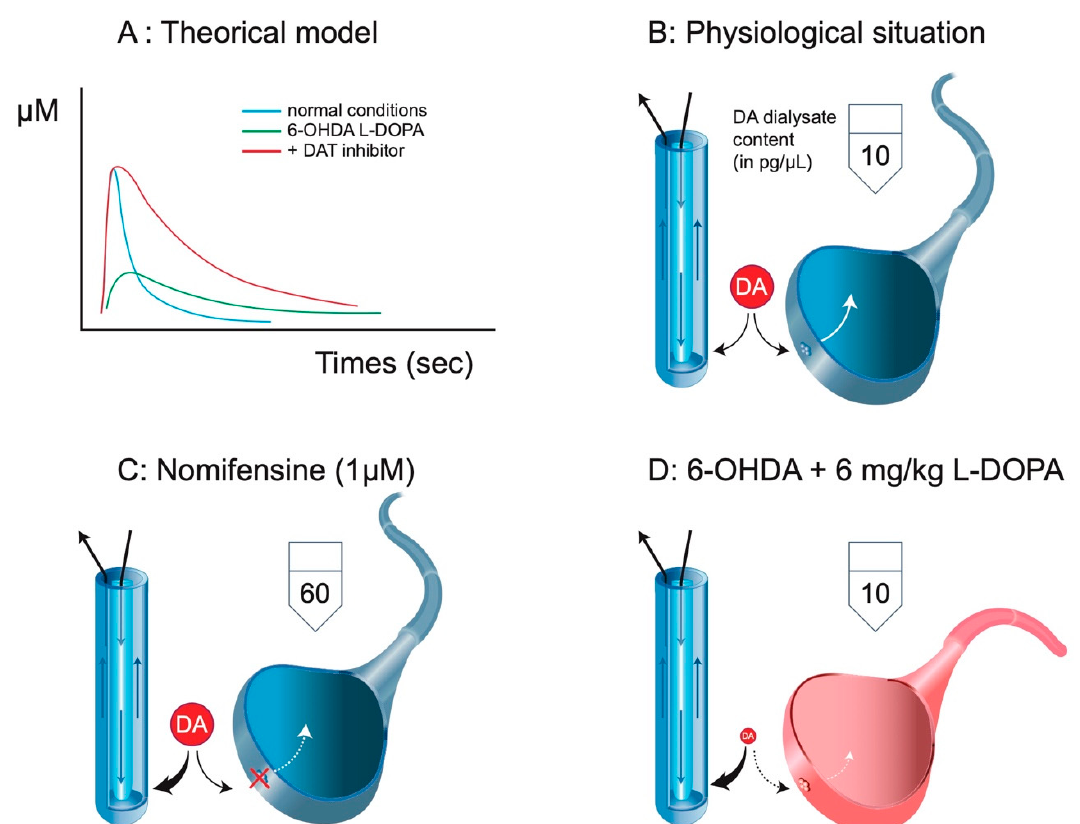
Figure 3. Clearance and intracerebral microdialysis. ( A ) Using fast cyclic voltammetric measurements, it is possible to illustrate the clearance of a neurotransmitter like DA. Upon stimulation, the signal (arbitrarily converted to µM) sharply reaches its maximum levels, and the clearance starts. It results in a rapid disappearance of the neurotransmitter from the extracellular space. In the presence of a DA transporter (DAT) blocker, the magnitude of the signal is not necessarily increased, but the rate of disappearance is dramatically reduced. In 6-OHDA conditions, the magnitude of the signal, if any, is lower, but the rate of disappearance is extremely low (no DAT). ( B ) Striatal DA extracellular levels correspond to a balance between the endogenous clearance and the exogenous clearance due to the microdialysis probe. In classic microdialysis experiments, the basal DA dialysate content in the striatum approximately reaches 10 pg/sample. ( C ) The local or systemic administration of a DAT blocker results in the increase in DA extracellular levels due to the loss of endogenous clearance and the increase in exogenous clearance (here, by sixfold according to [23]. ( D ) In 6-OHDA, there is no endogenous clearance of DA. The magnitude of the initial signal explaining the 10 pg obtained in the dialysate after 6–10 mg/kg L-DOPA is necessarily very low. Adapted from [20].